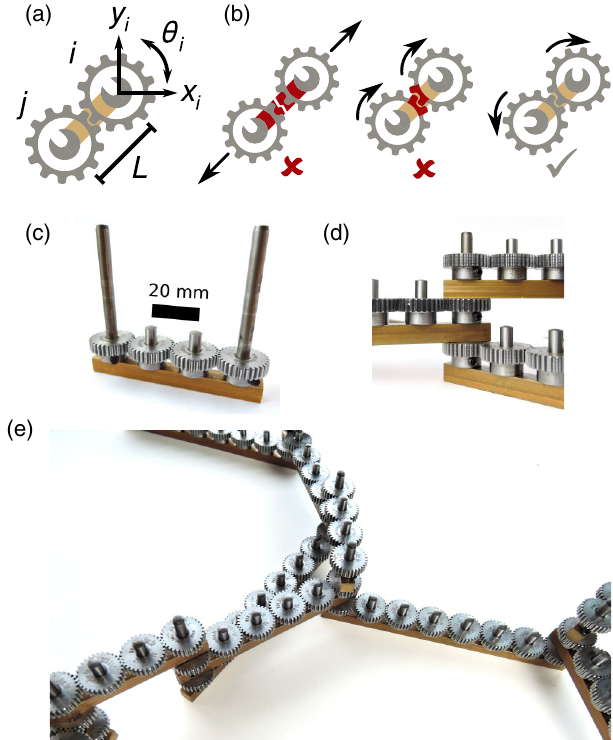
FIG. 1. Degrees of freedom and constraints in geared meta- materials. (a) The materials are built up of nodes with 3 degrees of freedom each: two translational ( x i , y i ) and one rotational ( θ i ). Nodes i and j are coupled by a single link, represented by the gray bar and the pair of gears that rotate together with the nodes. (b) The link constrains the distance between the nodes, and prevents rotations of the nodes in the same direction. However, counterrotations are allowed. (c) Realization of such an element using metal parts. The degrees of freedom associated with the long axles are coupled by gears mounted on a solid bar. The two gears at the ends rotate together with the long axles. The shear constraints are enforced using an even number of small gears to avoid self-intersections. (d) A joint that shares a single set of degrees of freedom, associated with the long axle, among three links. The links are stacked vertically to avoid self-intersections. (e) A unit cell consisting of a specific arrangement of six links that, when repeated, would form a geared size by chaining even numbers of gears together. The relevant degrees of freedom, associated with the long axles at the ends, are shared among bars at junction nodes [Fig. 1(d)].